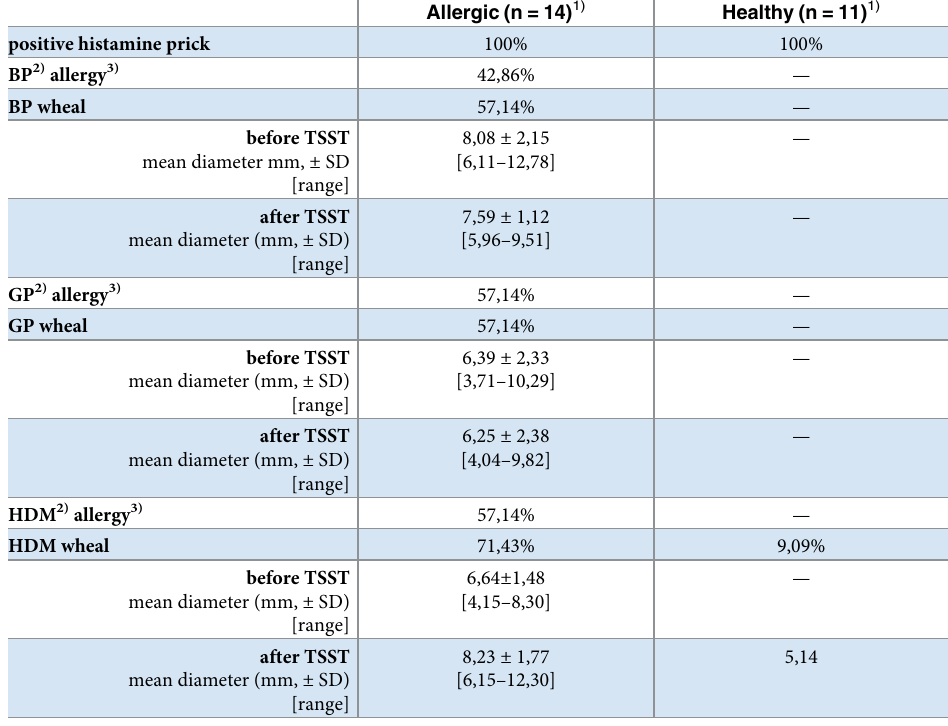
Table 2. Comparison of SPT results in the allergic and healthy cohort before and after the